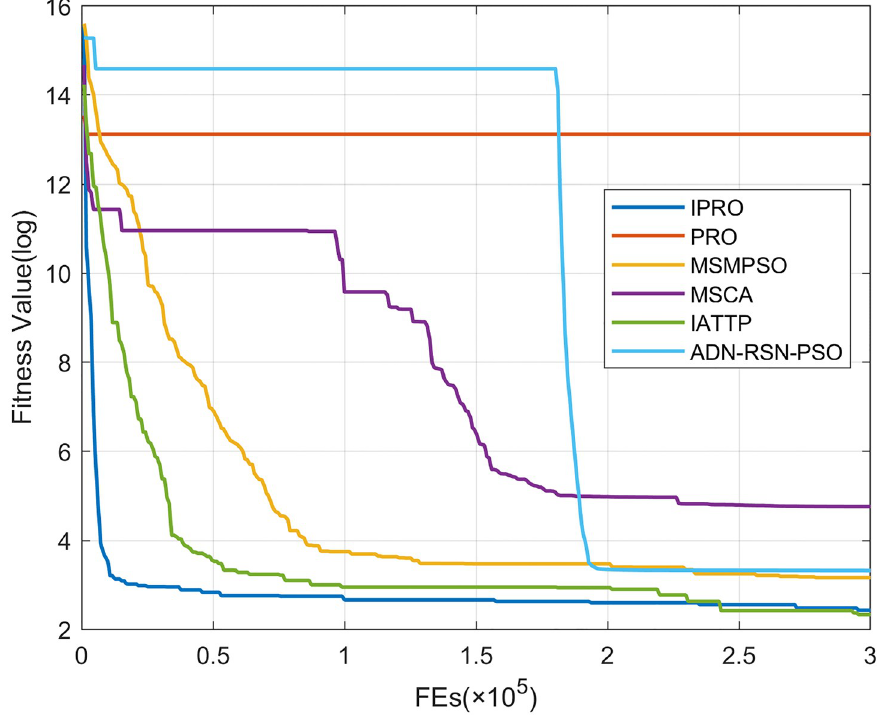
Fig 19. Convergence curves on F19.